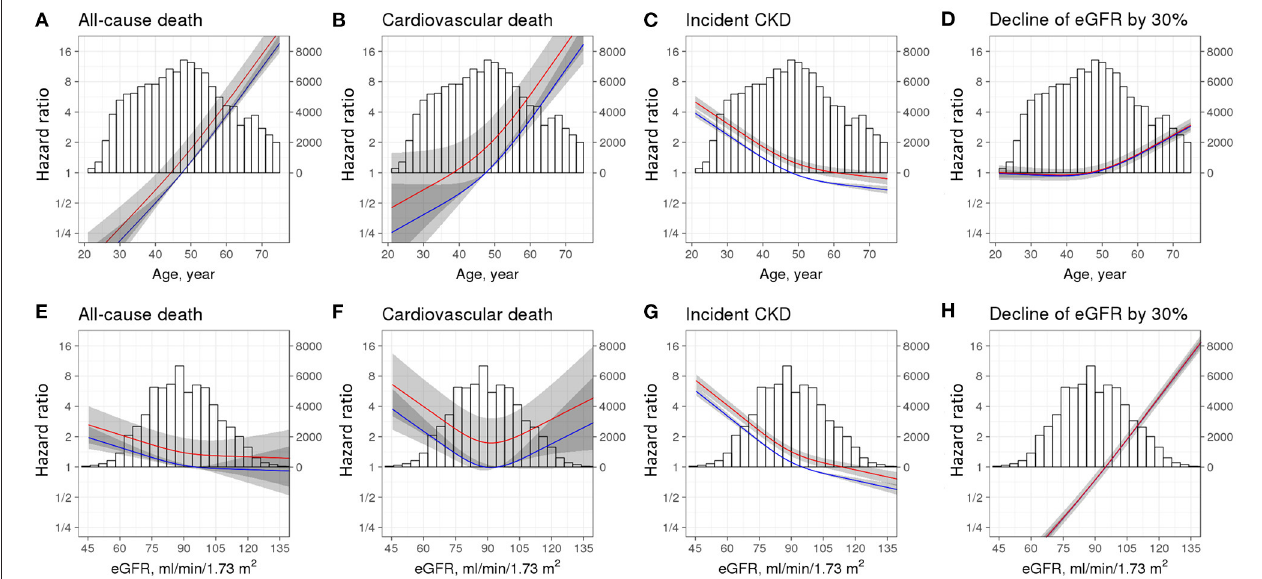
Frontiers in Cardiovascular Medicine |